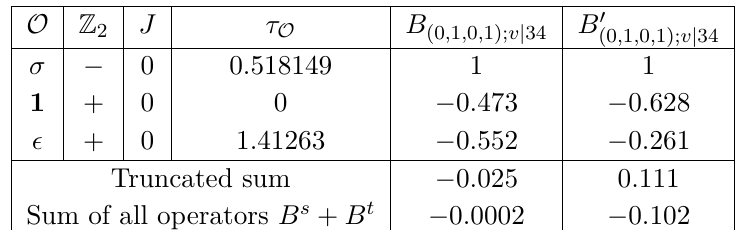
Table 11 . Contribution of each operator to the h (cid:15)(cid:15)σσ i sum rule with v = 1 ; these results include the contribution of the OPE coefficients f . The values are presented as ratios of the individ- O i O j O f O l O k O ual operator relative to the identity contribution. Empty cells contribute at order O (10 − 2 ) and less.